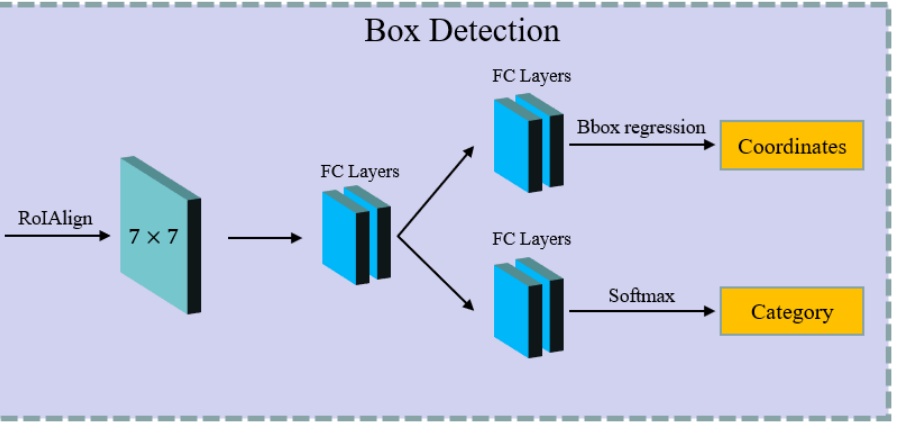
Figure 11. The pipeline of the box-detection branch.